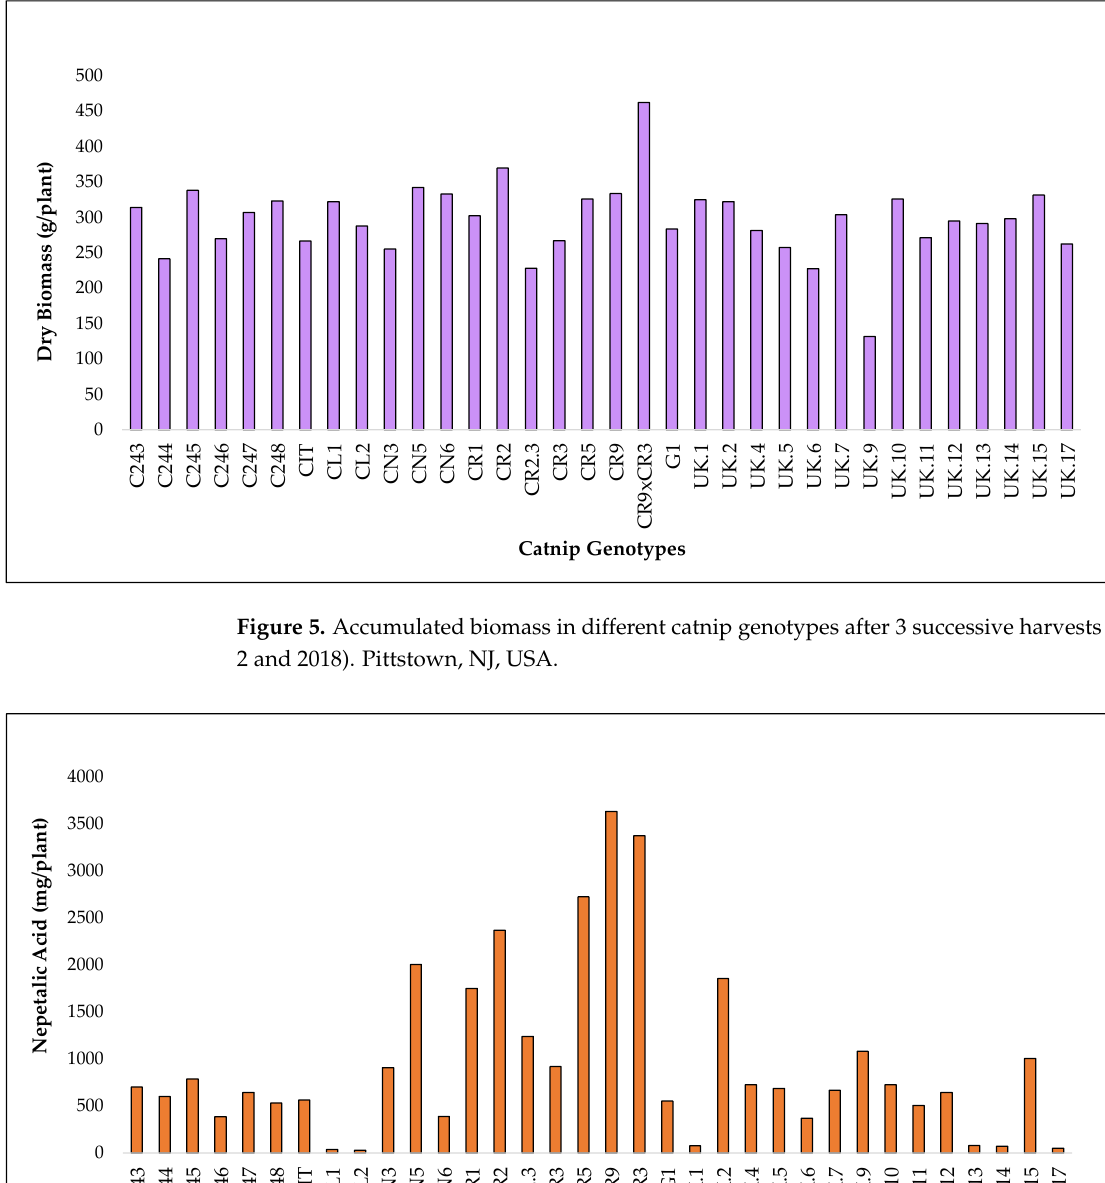
Figure 6. Accumulated yield of nepetalic acid in catnip genotypes after 3 successive harvests (2017 1 and 2 and 2018). Pittstown, NJ, USA.